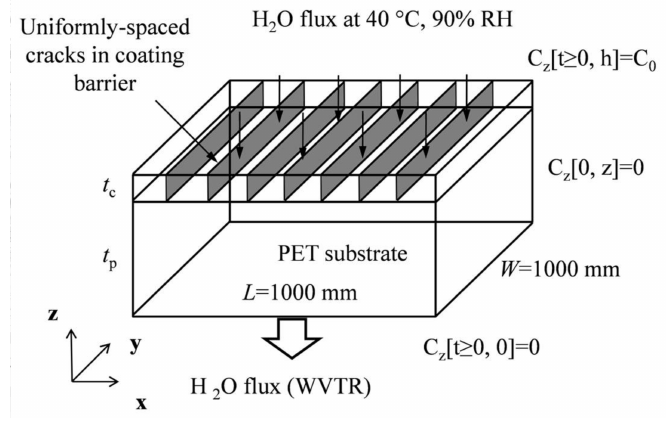
Figure 5. Schematic diagram of a 3D FEM model with uniformly-spaced cracks in the coating